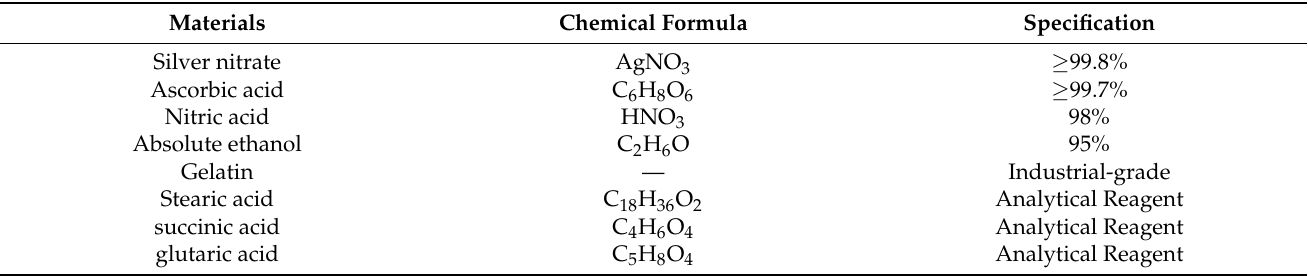
Table 1. Materials used in this